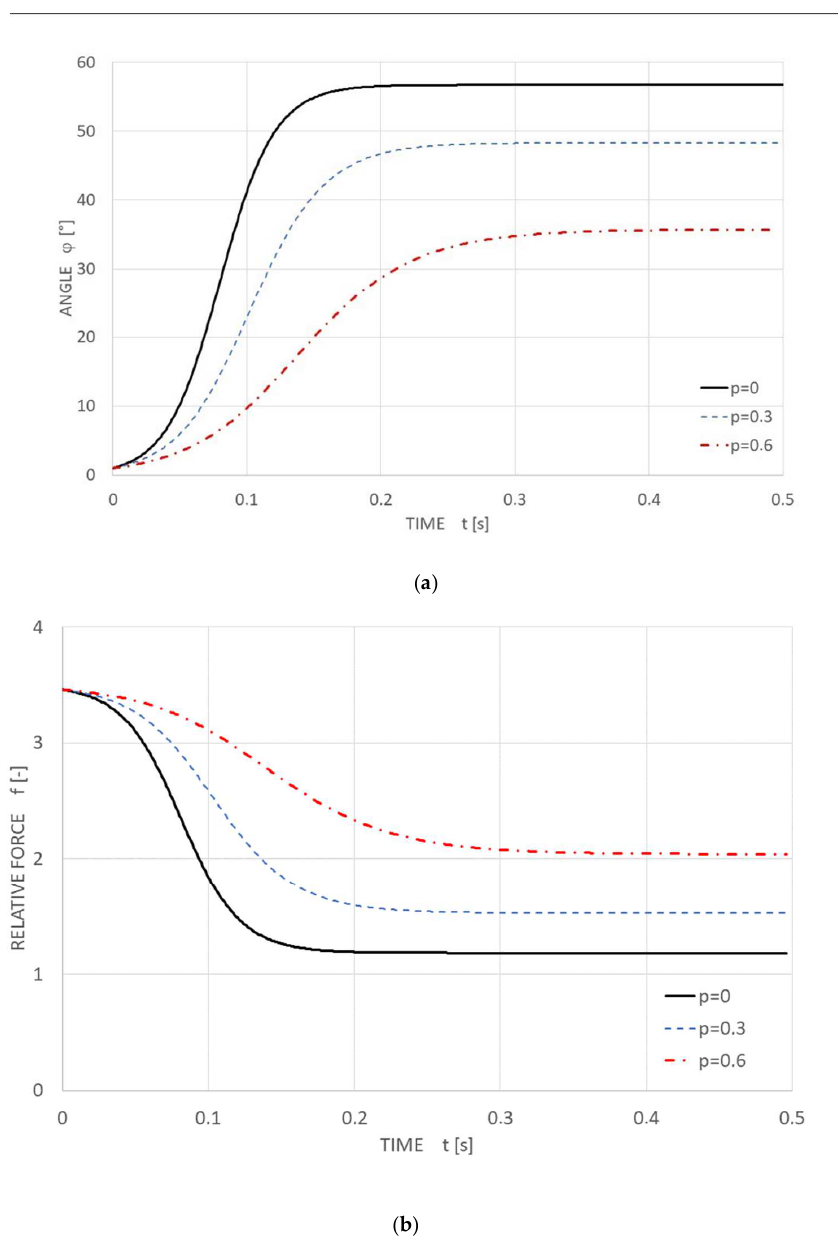
Figure 9. The plot of the functions φ = ( f 0 , p ). According to Equations (3) and (4), the time progression of the arm inclination angle φ in Figure 10a and the dimensionless fabric force f ( t , φ ) in Figure 10b, respectively, are in the time interval t from 0 to 0.5 s.